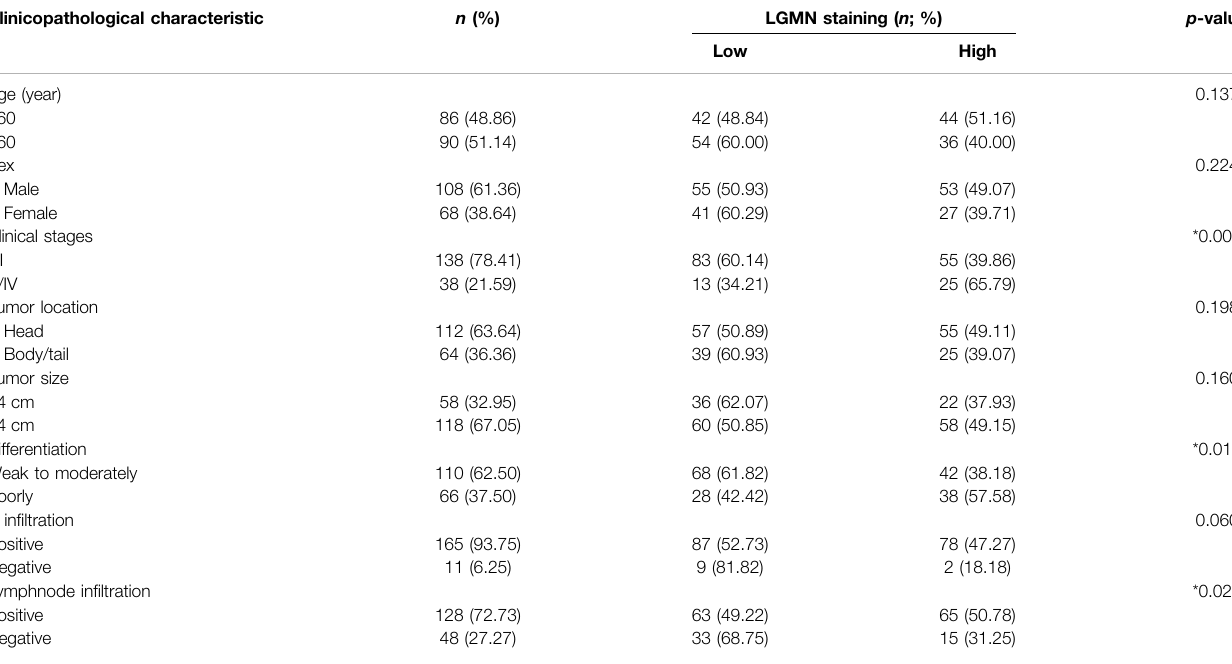
TABLE 1 | Association of LGMN expression with clinicopathological variables in pancreatic ductal adenocarcinoma. Clinicopathological